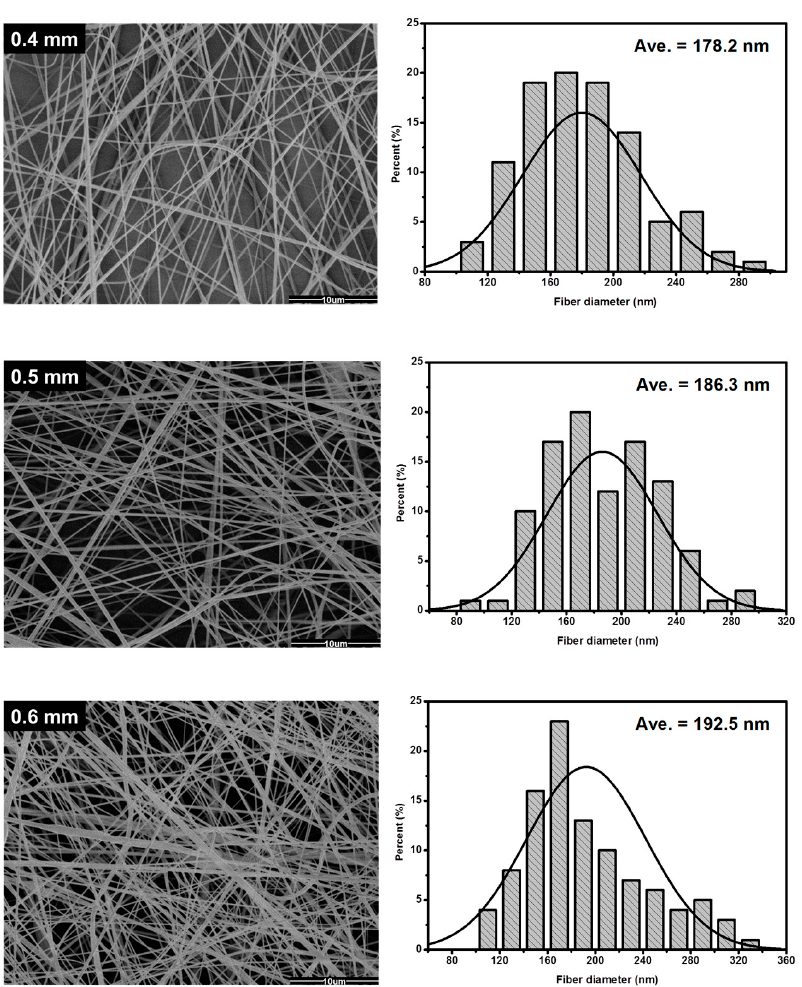
Figure 4. SEM micrographs and diameter distributions of solution blown PAA nanofibers at different nozzle diameters. PAA concentration, solution feeding rate, gas pressure and receiving distance were fixed as 8 wt %, 2.4 mL/h, 0.08 MPa and 20 cm, respectively.